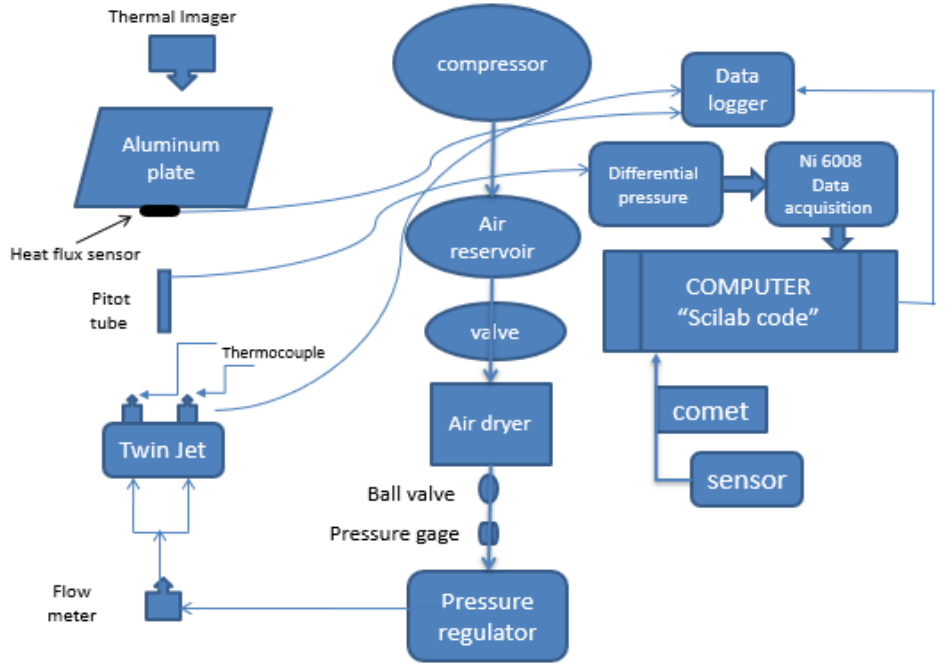
Figure 1. Schematic of twin impingement jets tests setup.